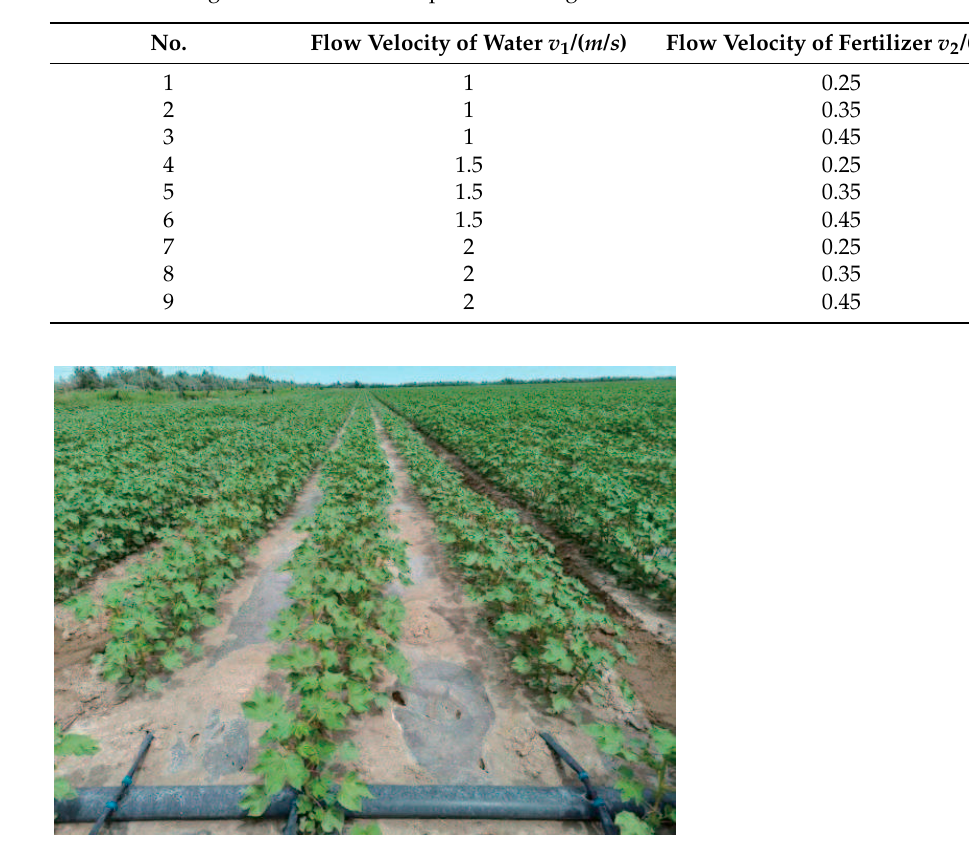
Figure 4. Experimental fertilizing equipment.